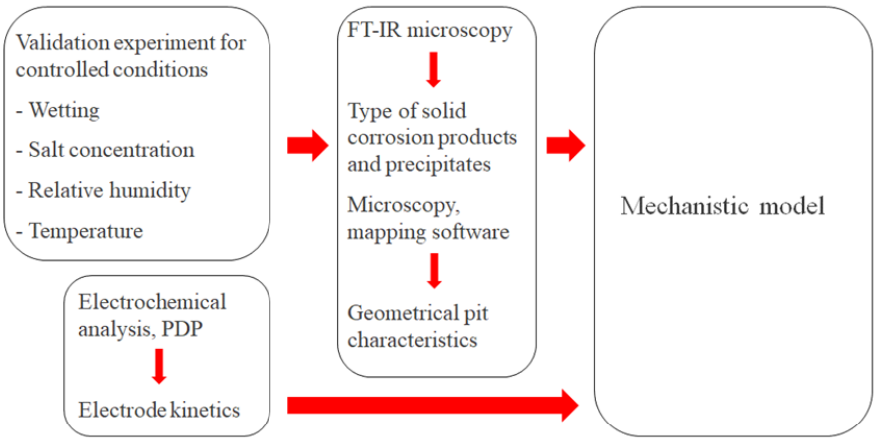
Figure 5. Overview of the strategy to calibrate and parametrize the mechanistic atmospheric corro- sion model. sion